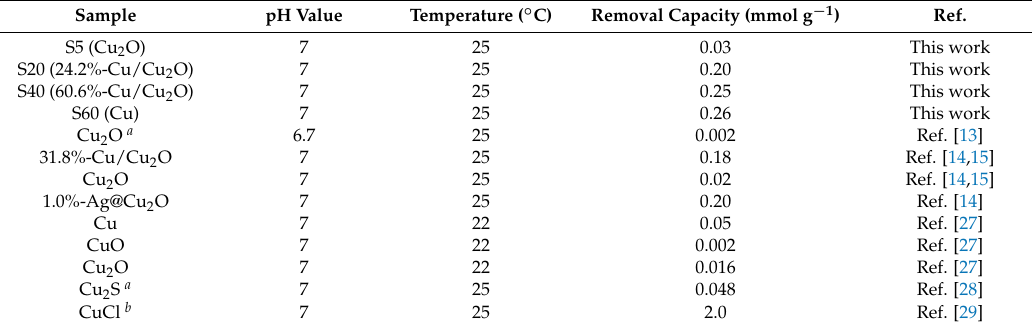
Figure 4. ( a ) Uptake isotherms of all hollow Cu-based adsorbents for I − anions over 12 h; ( b ) uptake kinetics of all hollow Cu-based adsorbents in 0.4 mM I − anions. Table 1. Comparison of the iodide uptake capacities of several previously reported Cu- based adsorbents. Sample pH Value Temperature ( ◦ C) Removal Capacity (mmol g − 1 )